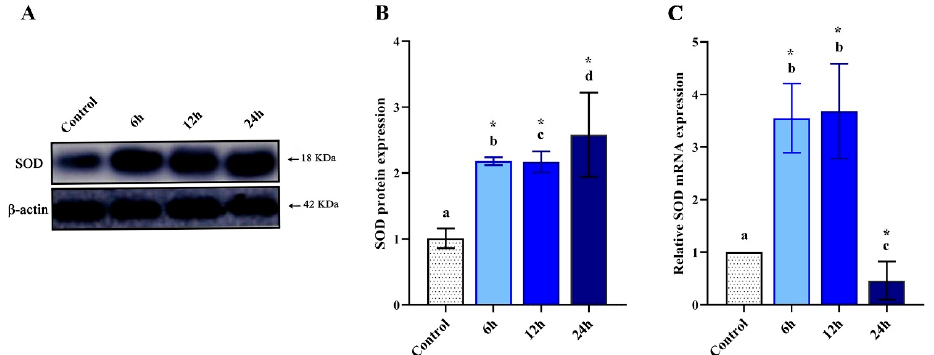
Figure 2. Changes in Md SOD1 expression of control and LPS-treated M. domestica larval hemolymph. ( A ) The representative photograph of protein expression analyzed by Western blotting. ( B ) A graph shows the analysis of protein bands (Gel Doc Go System, Bio-Rad, Hercules, CA, USA). ( C ) A graph shows the relative Md SOD1-mRNA expression analyzed by qRT-PCR. B and C, different letters indicate significant difference ( p < 0.05). * indicate high significance with respect to control ( p < 0.01). Data were presented as mean ± SD. The experiments were done in triplicate ( n = 3).